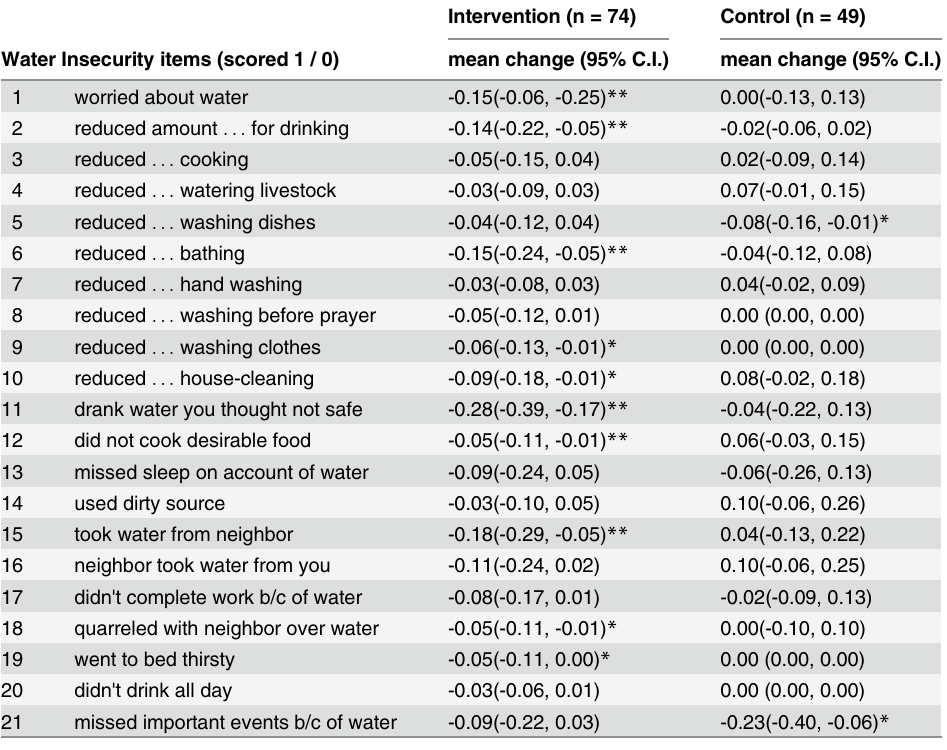
Table 3. Changes in experiences of household water insecurity between baseline and endline, in intervention and control groups (paired t-tests). Intervention (n =